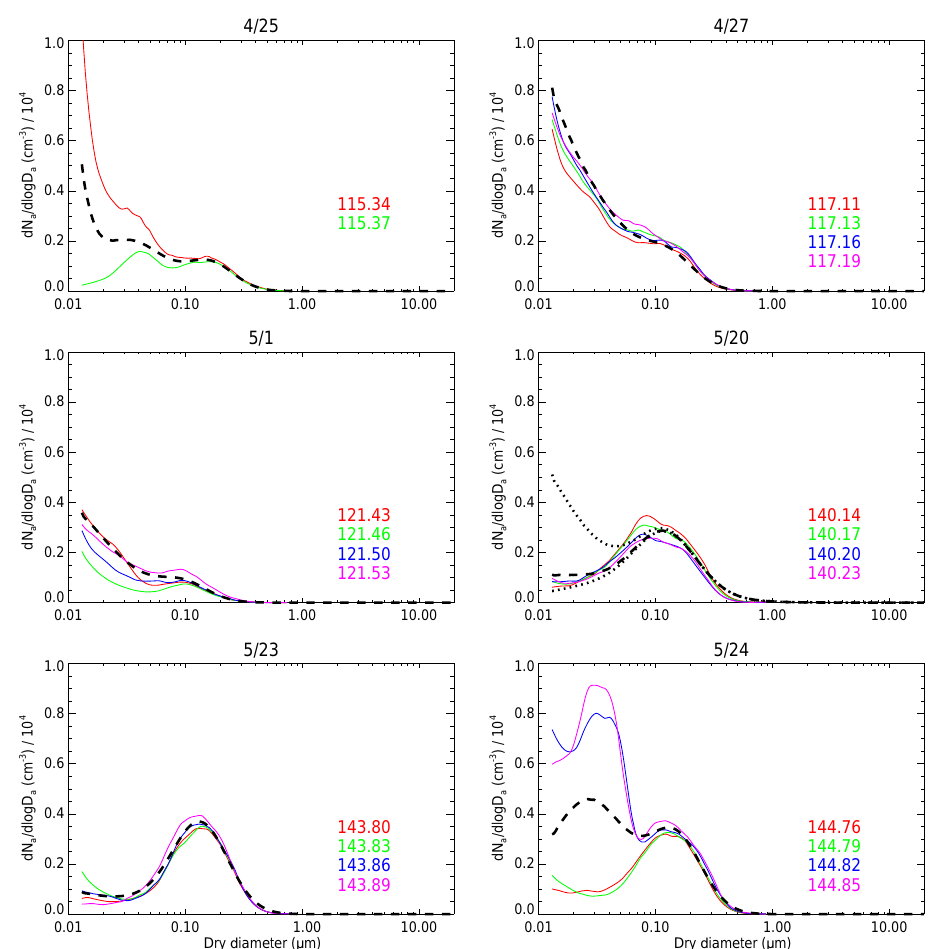
Figure 6. Aerosol dry number size distributions reported from HTDMA during the 2h pre-rain period (colored solid lines; legend indicates Julian date in UTC) and the mean size distribution derived for each case study (black dashed lines; archived with Supplement 1). In the 20 May case, 0 and 8000cm − 3 particles in the nucleation mode illustrate the baseline (BASE) and sensitivity test (NUCL) simulation inputs (dotted black